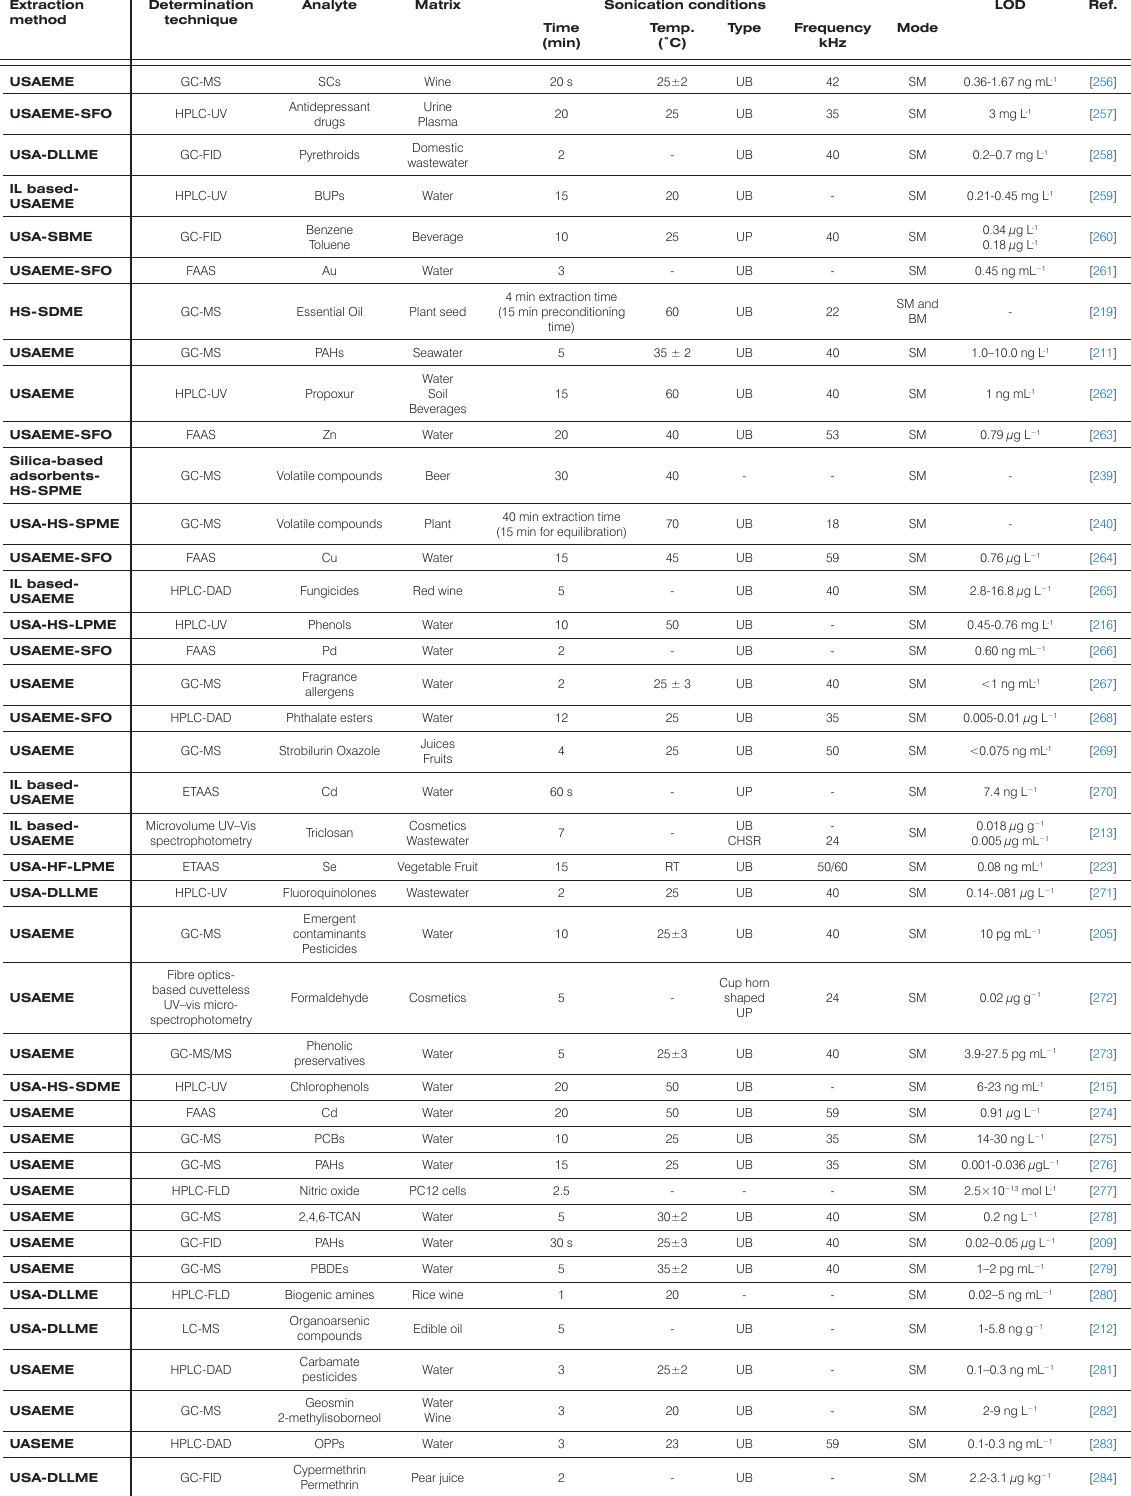
Table 6. Extraction